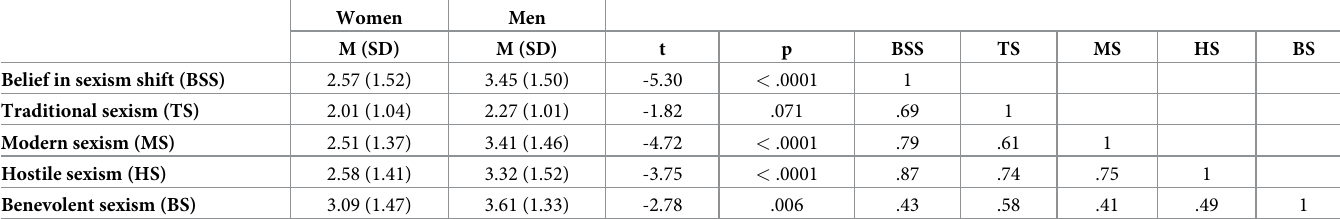
Table 5. BSS scale means, standard deviations, and correlations with other sexism scales (traditional sexism, modern sexism, hostile sexism, and benevolent sexism).